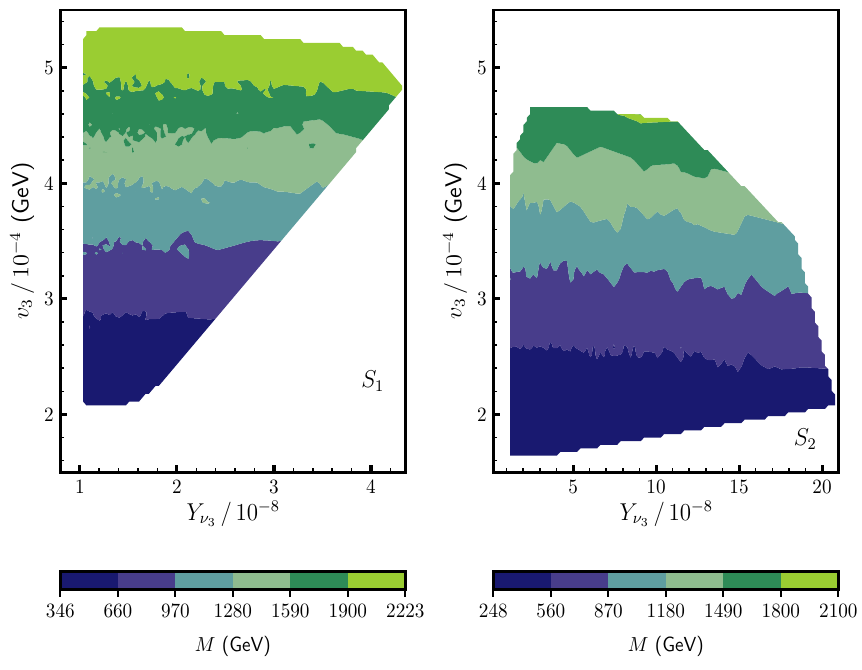
Fig. 3 v 3 versus Y ν for scan 3 S 1 (left) and scan S 2 (right). The colours indicate different values of the gaugino mass parameter M defined in Eq.